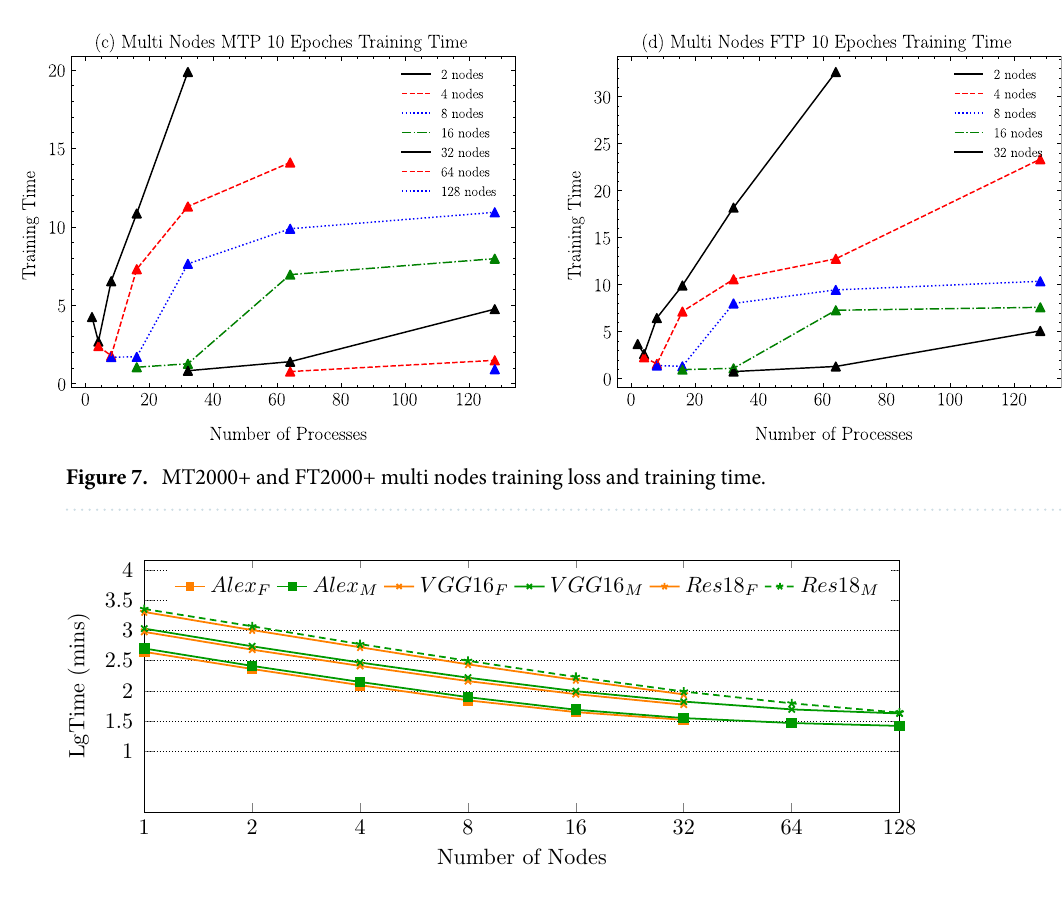
Figure 8. AlexNet, VGG16, and ResNet18 trainig